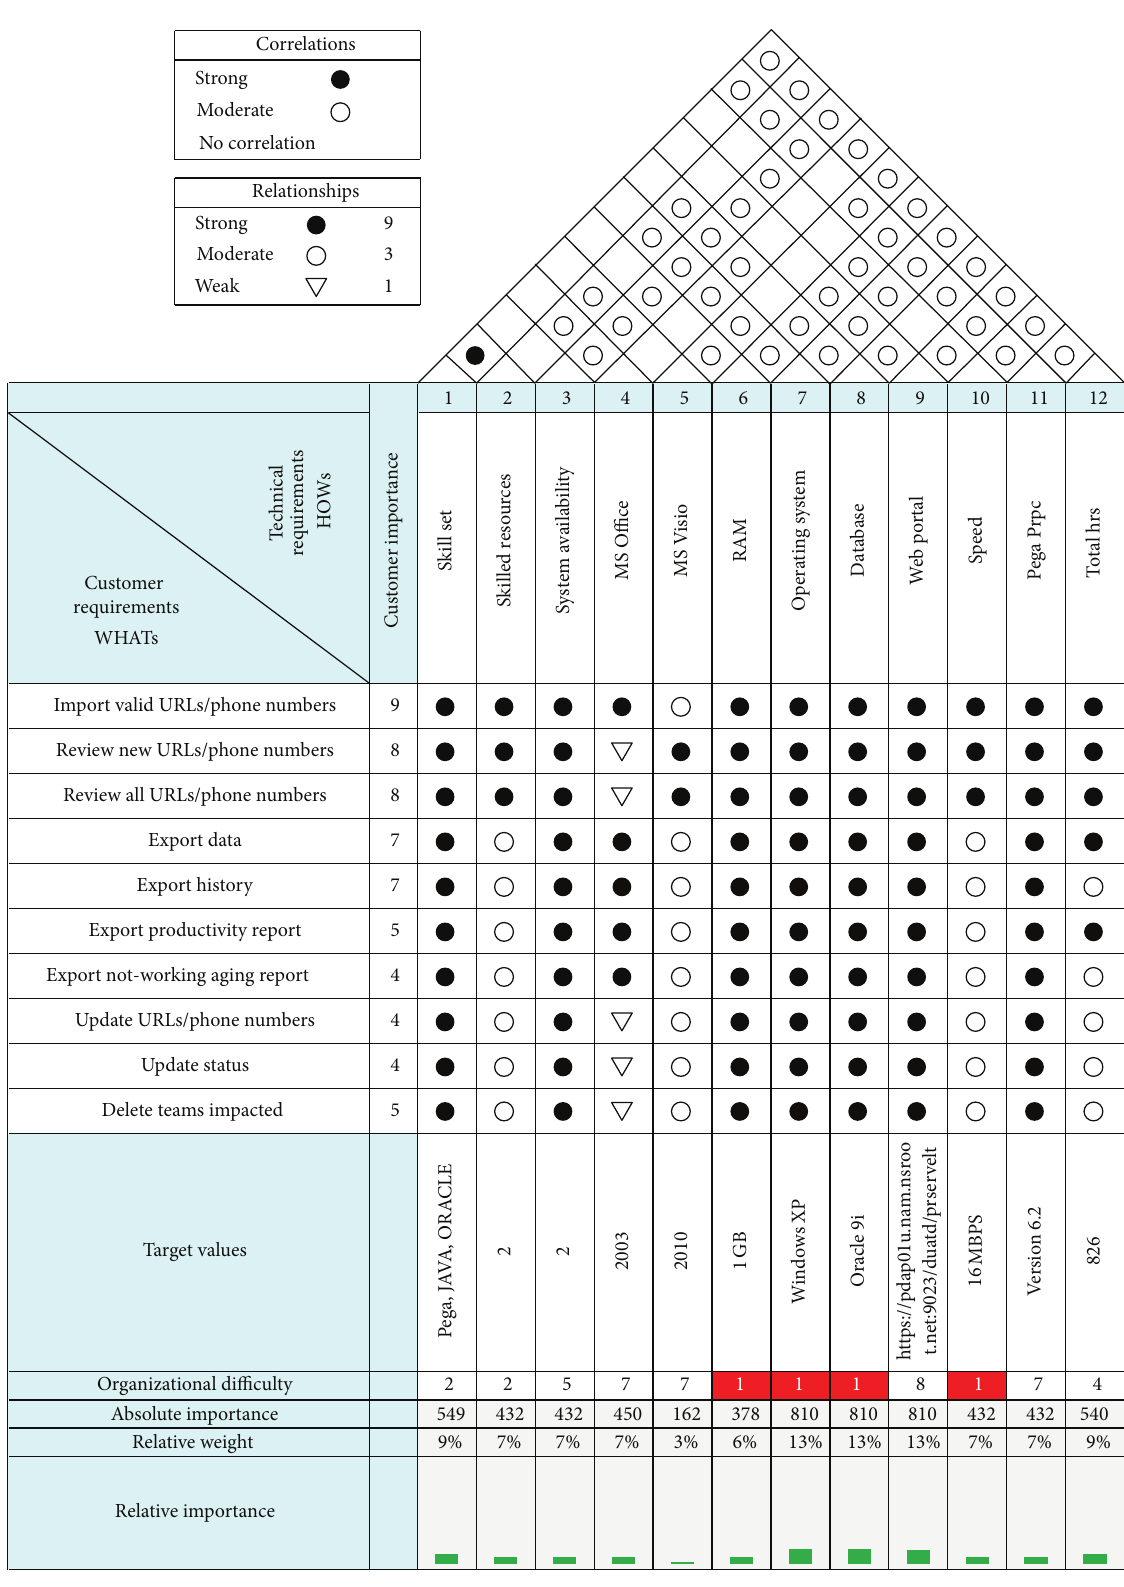
Figure 5: Software quality deployment diagram for finding correlations and relationships of customer requirements and functional